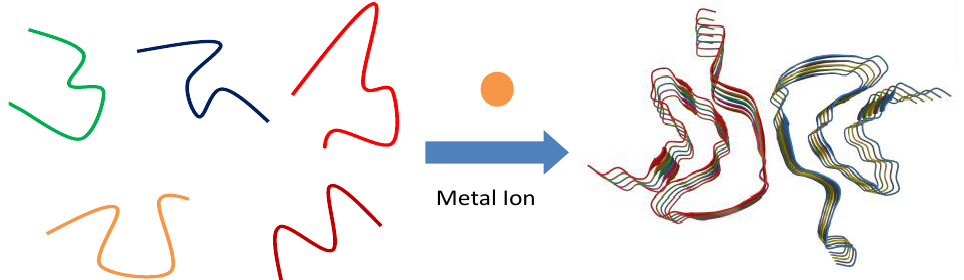
Figure 6. Modulation effect of metal ion on the morphology of α -synuclein through conformational plasticity mechanism.